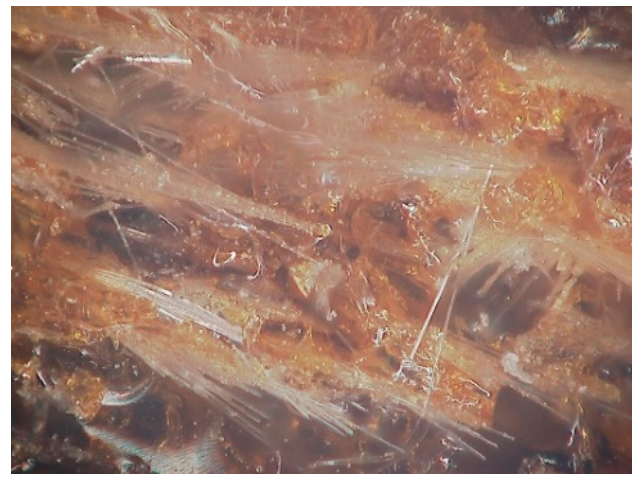
Figure 10. The fracture surface of 30 wt.% GF/p-DCPD composite.